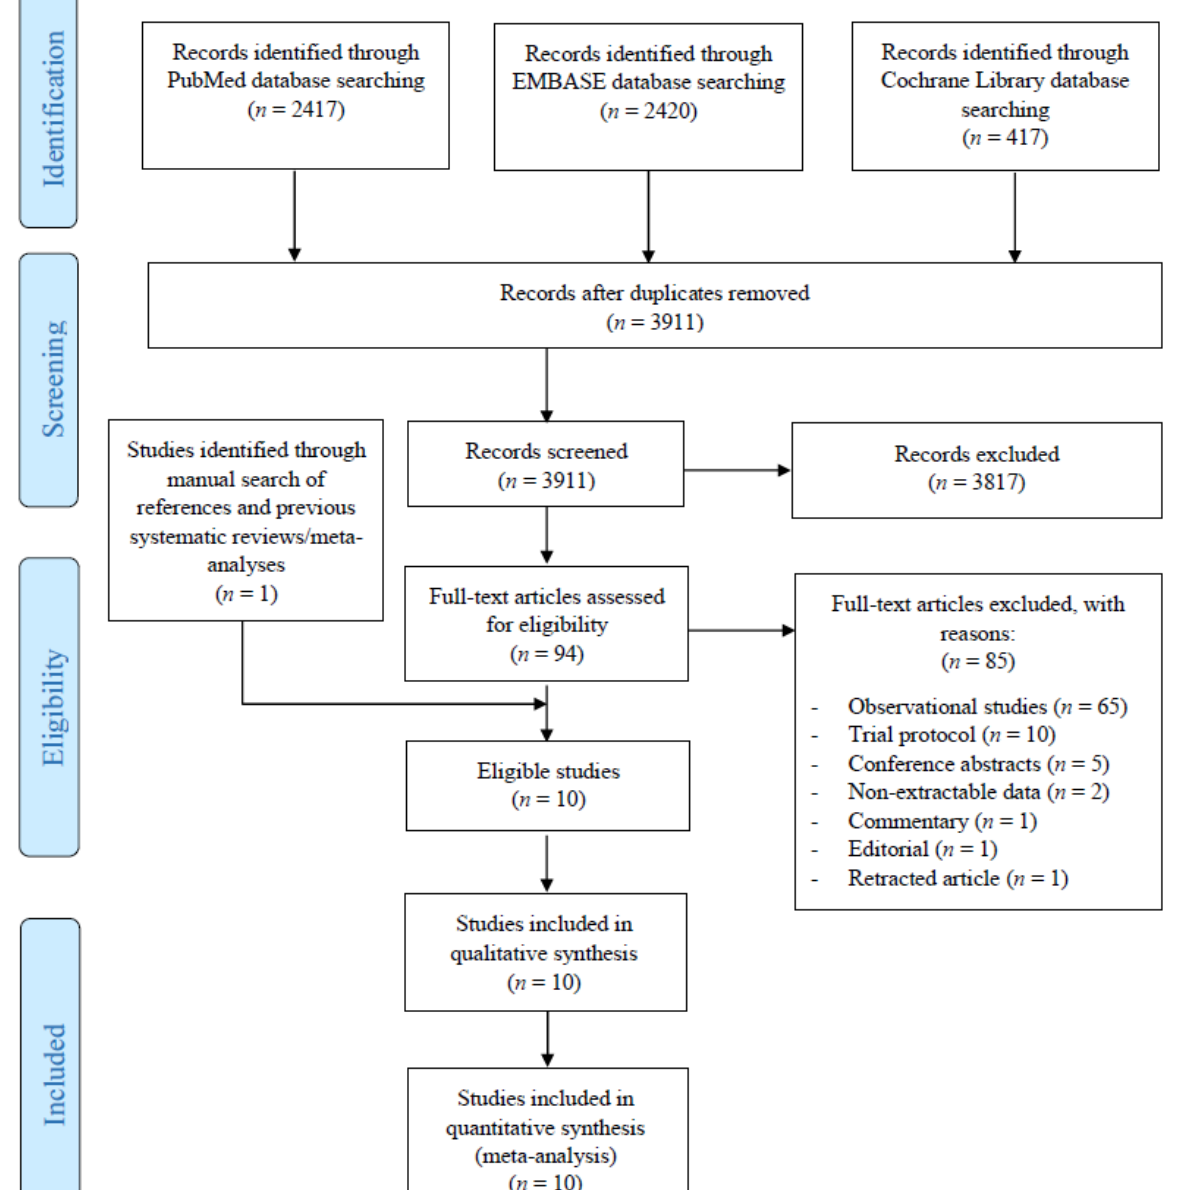
Figure 1. Preferred Reporting Items for Systematic Reviews and Meta-Analyses (PRISMA) flow diagram of the study selection process.